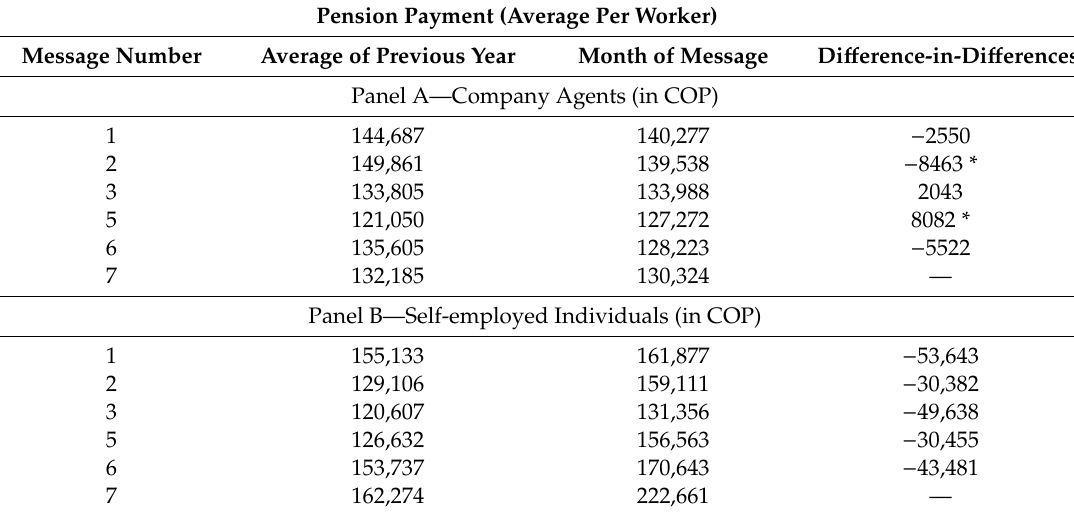
Table 4. Pension Payments with “Neutral Message 7 as Control Group”—